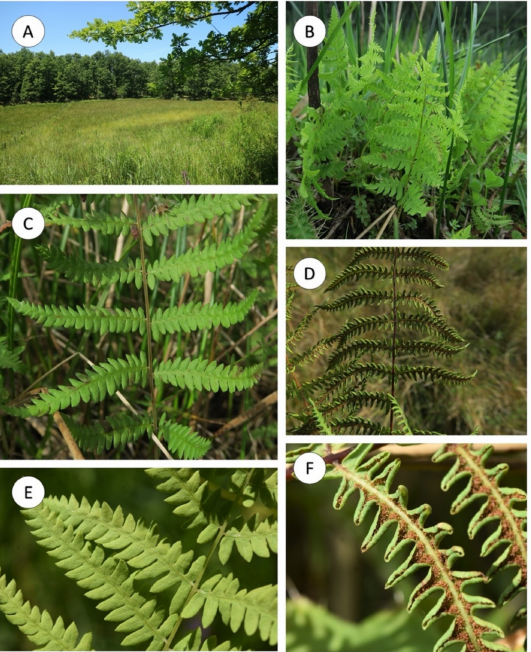
Figure 2. Some views of the new Sicilian population of Thelypteris palustris Schott subsp. palustris ; ( A ) Growth environment (Nebrodi Mountains); ( B – E ) Habit; ( F ) Sporangia (Photos of the